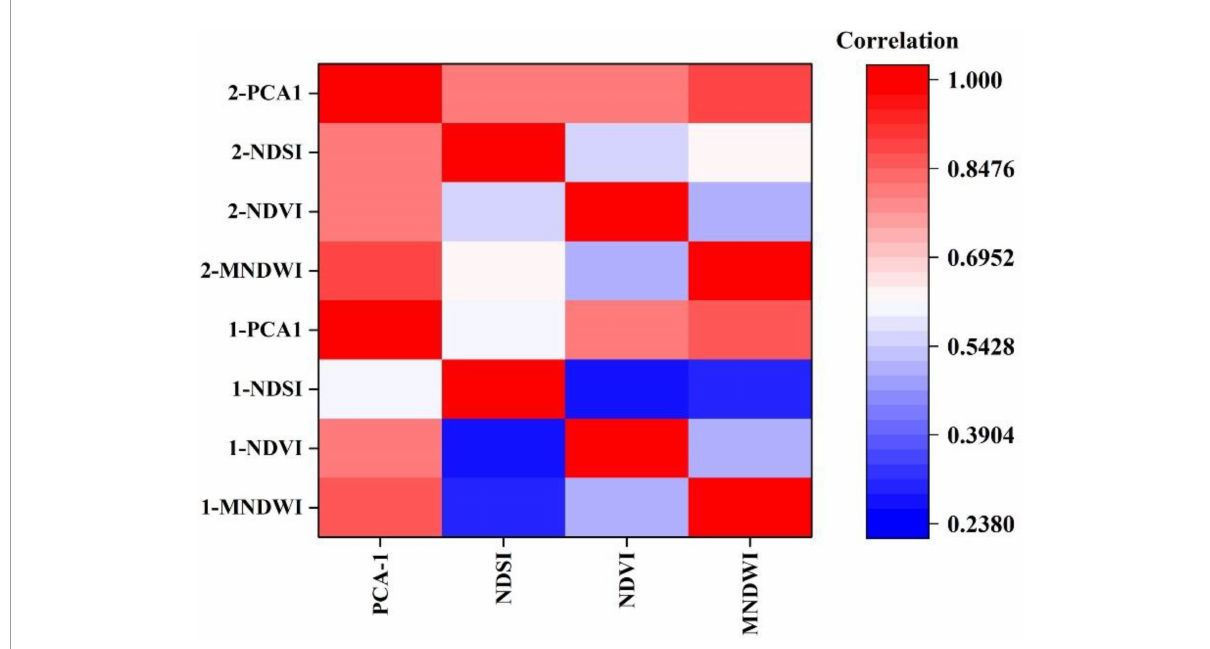
FIGURE4 The correlation matrix of PC-1 and three factors. 1-, Shuangtai Estuary; 2-, Yellow River Delta.